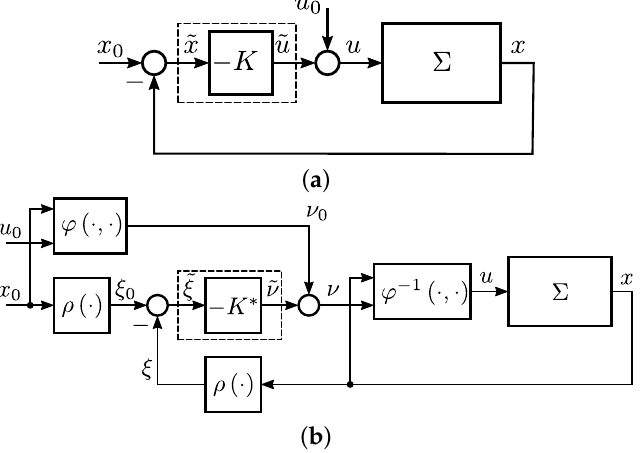
Figure 2. Locally equivalent control structures (linear parts are denoted by dotted lines): ( a ) Classical linear controller, ( b ) Nonlinear controller using linear feedback in new set of